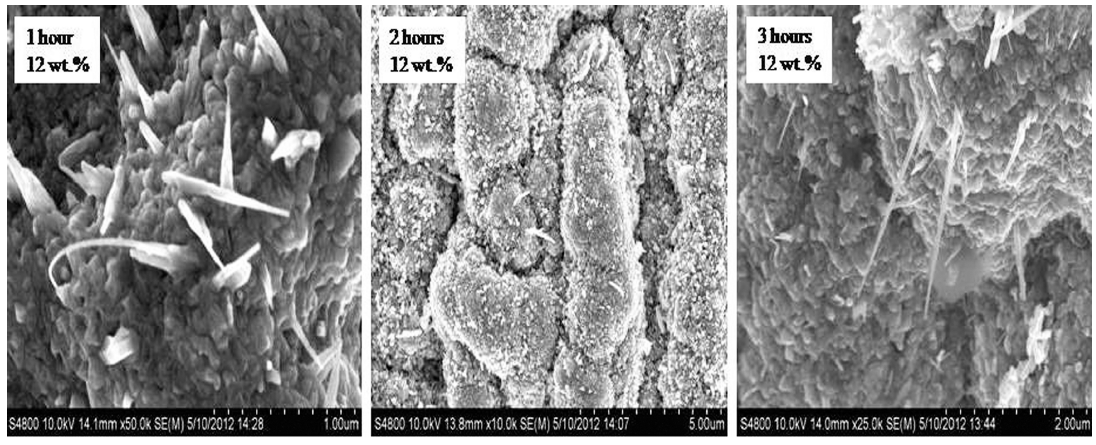
Figure 4. SEM images of oxide morphology on thermal oxidation of Cu-32.02% Zn-2.30% Pb alloy in N